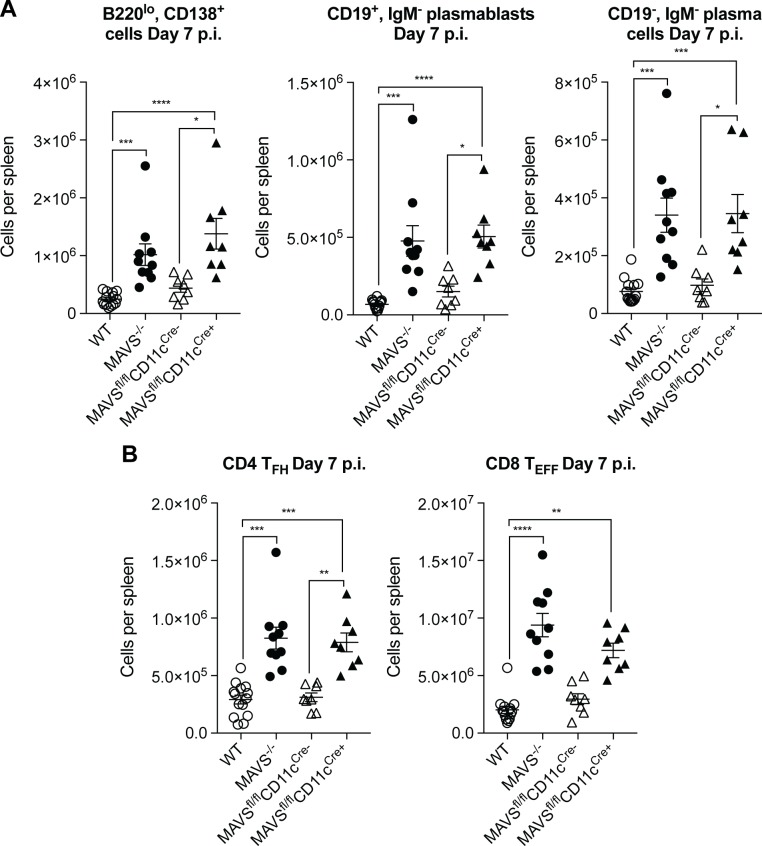
WNV infection induces increased numbers of plasma cells, TFH cells and CD8+ T effector cells when MAVS is conditionally deleted from CD11c+ cells.WT, MAVS KO, MAVSfl/fl, MAVSfl/flCD11cCre-, MAVSfl/flCD11cCre+, MAVSfl/flMb1Cre- and MAVSfl/flMb1Cre+ mice were infected with 100PFU WNV-MAD. (A) CD3-, B220lo, CD138+ cells, IgM-, CD19+ plasmablasts and IgM-, CD19- plasma cells from total splenocytes were evaluated by flow cytometry. (B) CD4+ T follicular helper cells (CD4 TFH), and CD8+ T effector cells (CD8 TEFF), defined as in Fig 2, were evaluated from the spleen by flow cytometry. Data are combined from two individual experiments. *p<0.05, **p<0.01, ***p<0.001 by Kruskal-Wallis test with Dunn’s multiple comparison test.